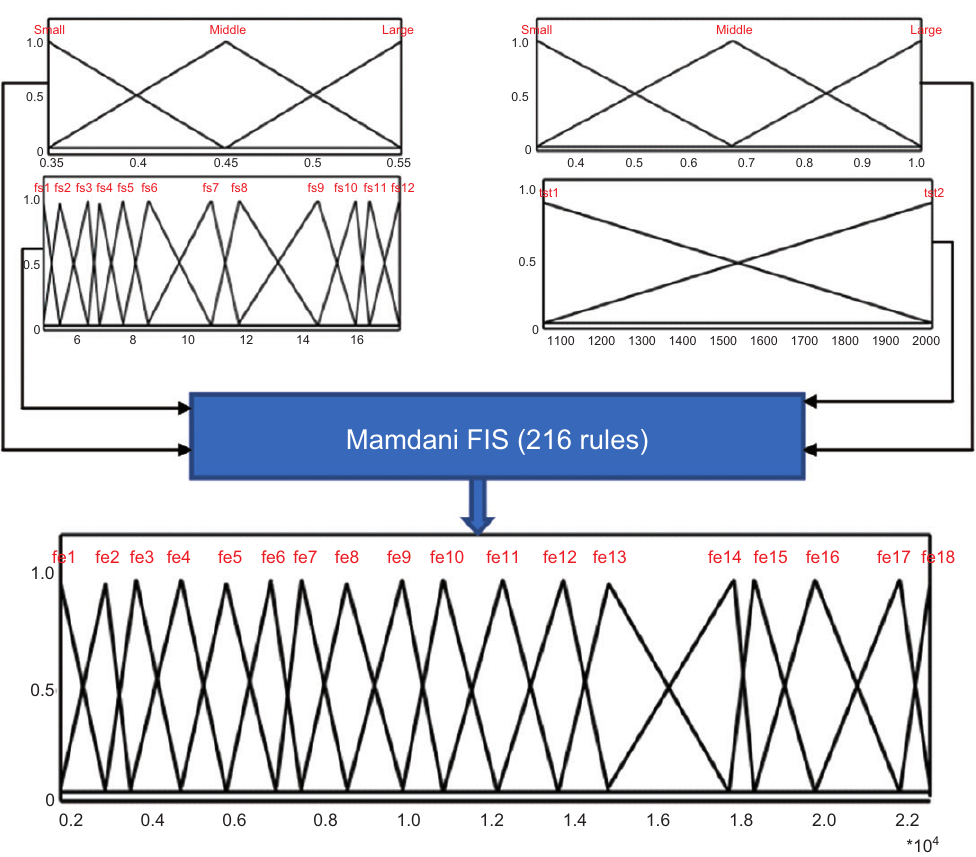
Figure 4 Membership functions of inputs and outputs of the model.